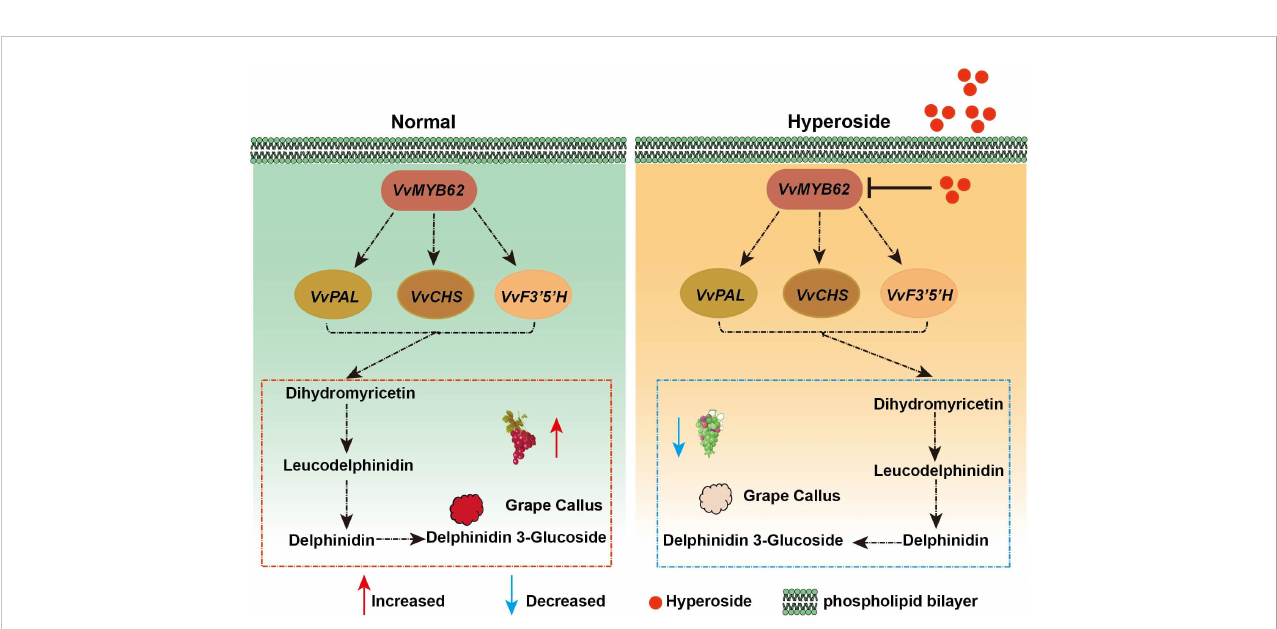
FIGURE 9 The metabolic routes for anthocyanin in grape fruits in response to hyperoside treatment are depicted in the working model. We put forth a molecular method that would prevent the production of anthocyanin by boosting VvMYB62 expression by spraying hyperoside on grape fruit. The expression level of VvMYB62 might be elevated and anthocyanin accumulation could be further encouraged in the absence of hyperoside. However, when grape fruits were given further hyperoside treatment, VvMYB62 expression was repressed and anthocyanin accumulation was